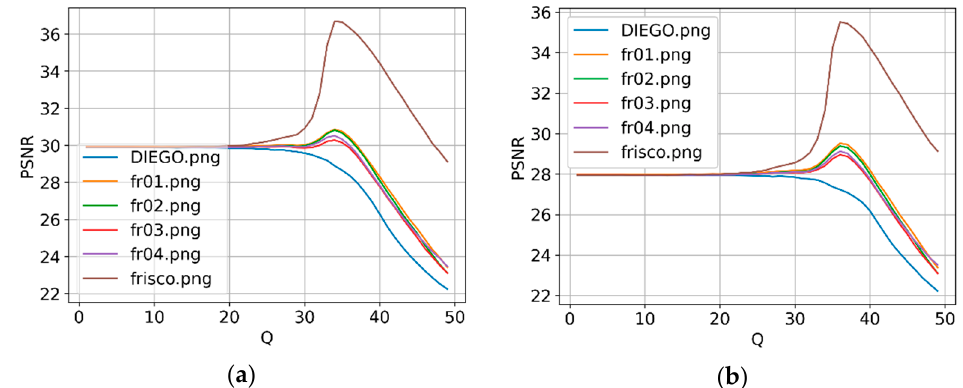
Figure 6. Dependences PSNR tc ( Q ) for noise variance equal to 64 ( a ) and 100 ( b ).